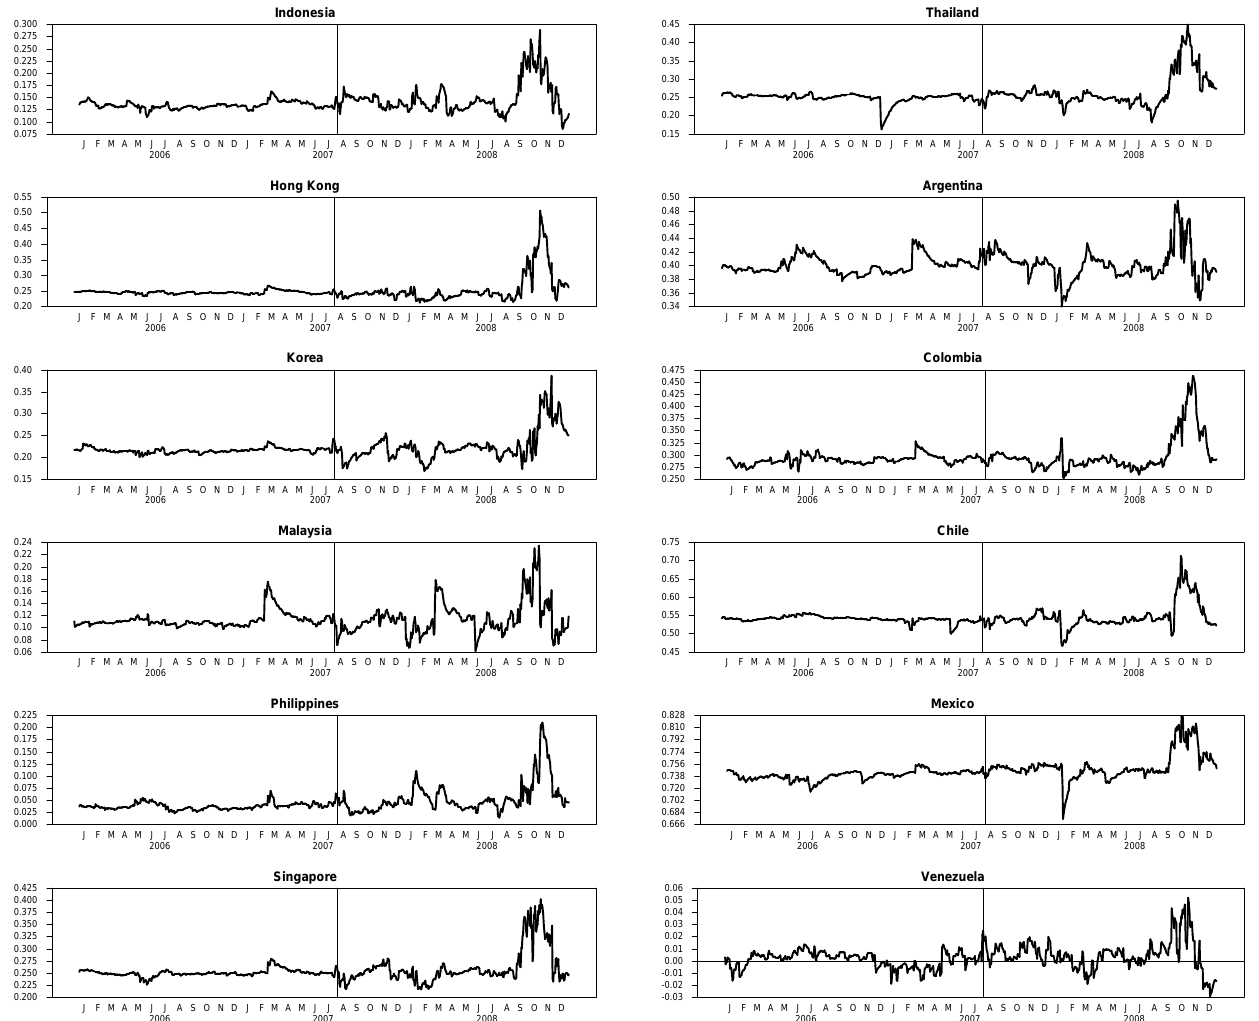
Figure 4. The dynamic correlation estimation for the US Subprime crisis. The vertical continuous line represents the break date: 1 August